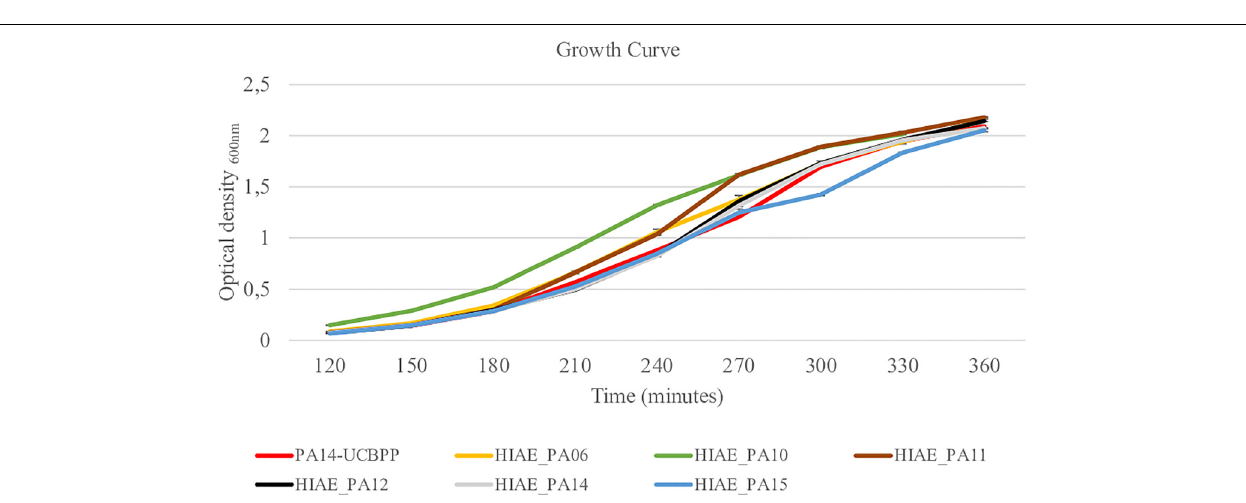
Frontiers in Microbiology |